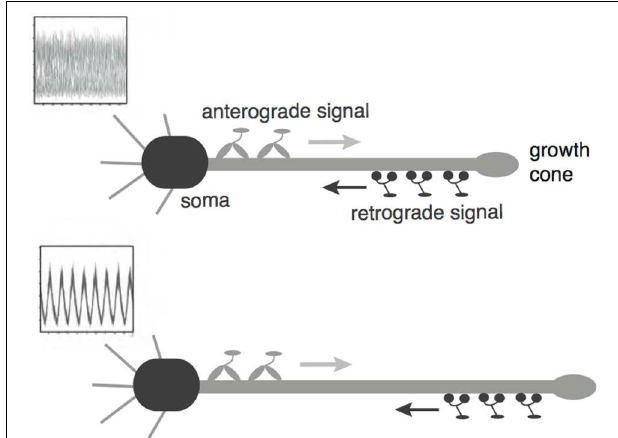
FIGURE 1 | Schematic diagram of the bidirectional motor-transport mechanism for axonal length sensing hypothesized by Rishal et al. (2012). A kinesin-based anterograde signal activates a dynein-based retrograde signal that itself represses the anterograde signal via negative feedback. The frequency of the resulting oscillatory retrograde signal decreases with axonal